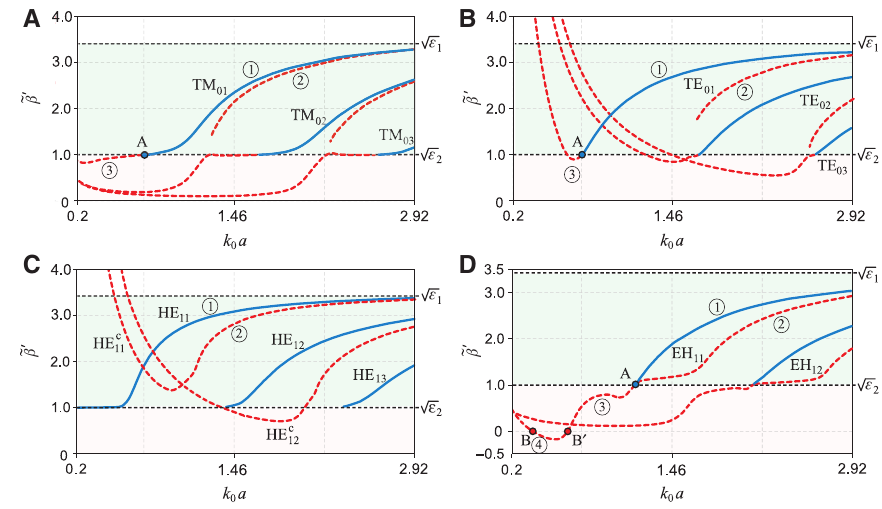
Figure 2: Dispersion characteristics of trapped surface and leaky waves. The dispersion curves of axially symmetric (A) TM Fragments of curves colored in blue (solid lines) and denoted by ➀ correspond to the trapped surface waves (guided modes), whereas those colored in red (dashed lines) and denoted by ➁ , ➂ , and ➃ correspond to the leaky waves (radiative modes). The points denoted by A mark the cutoff frequencies, whereas points denoted by B and B ′ mark the frequencies of transition between different types of the leaky waves.